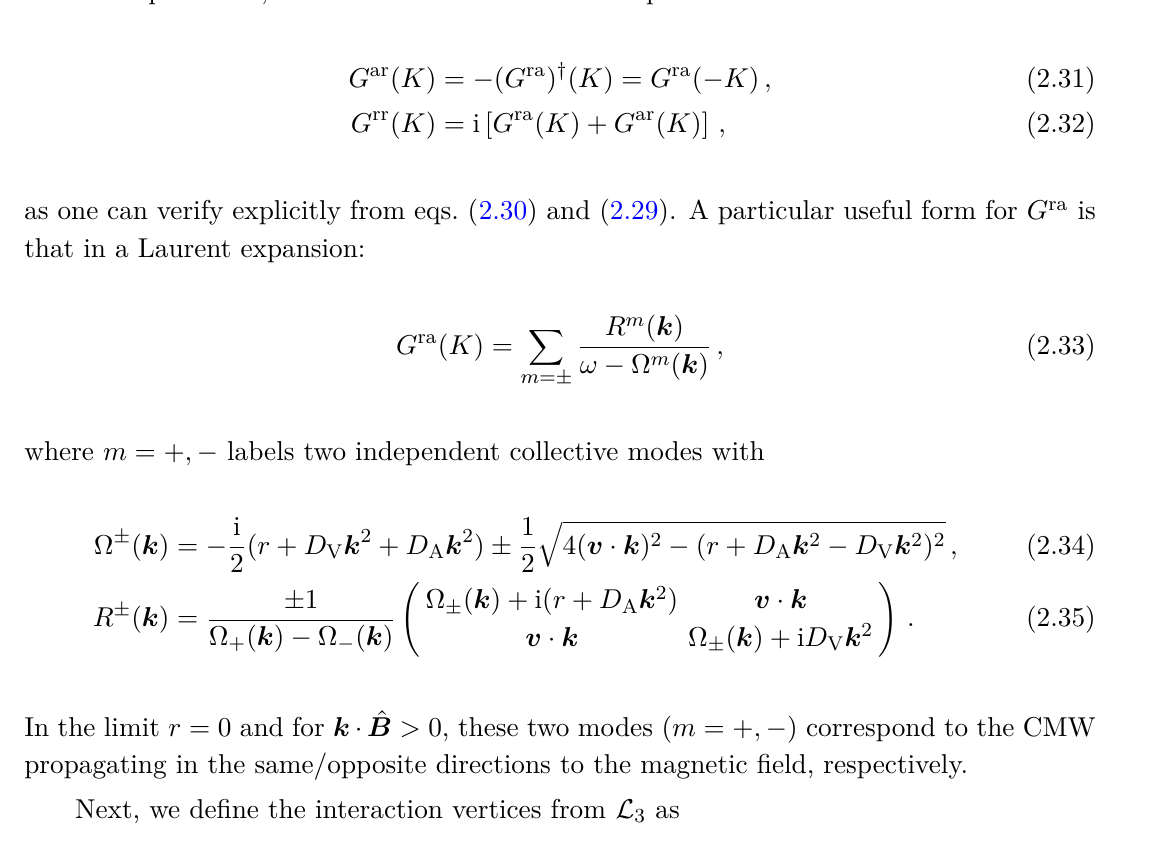
Figure 1 . Diagrammatic representations of (a) G ra The solid and dotted lines correspond to λ (r-field) and ψ (a-field),